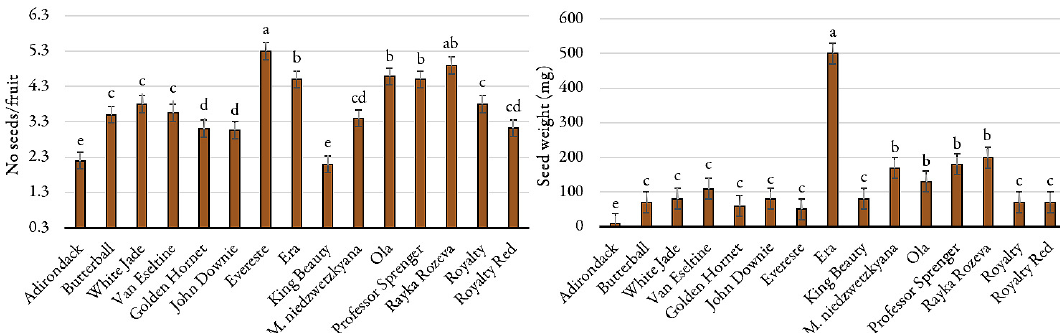
Figure 5. The main seeds characteristics of the 15 cultivars of ornamental crabapples